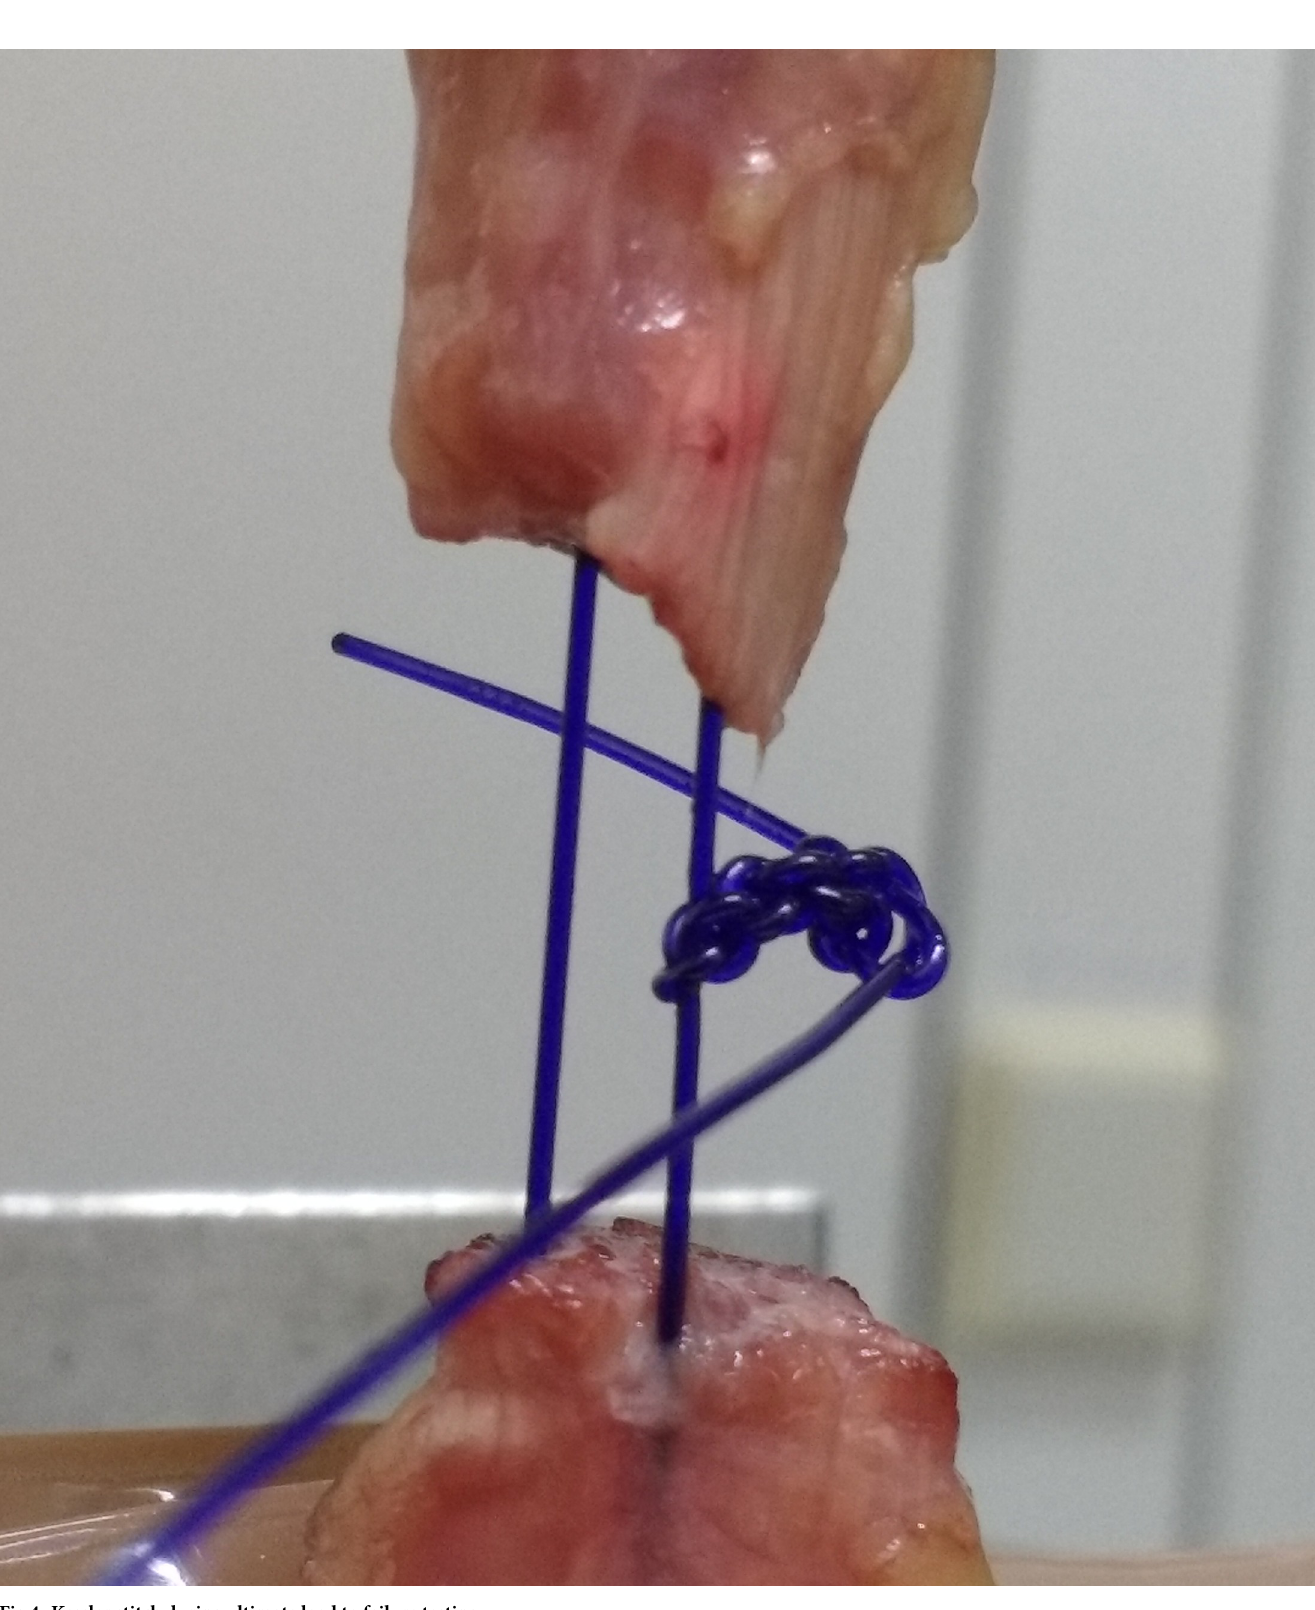
Fig 4. Kessler stitch during ultimate load to failure